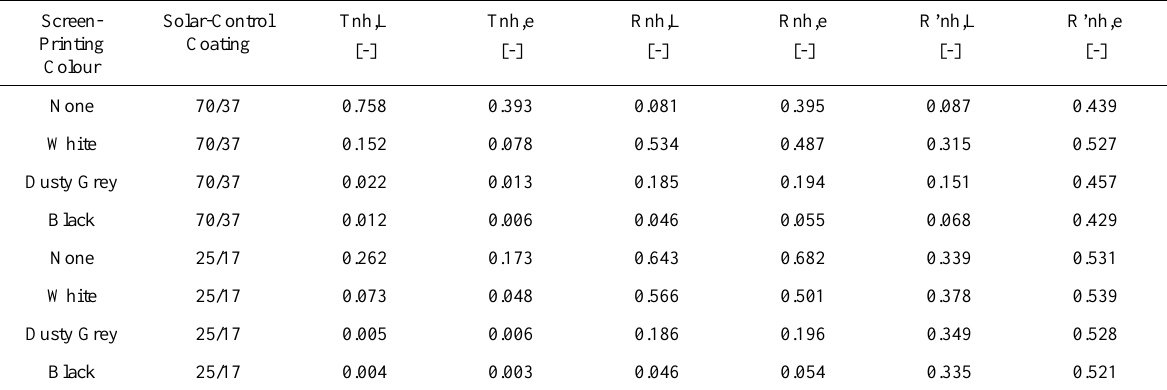
Table 2: Transmittance and reflectance values according to EN 410:2011 for 8 mm low-iron glass panes with a solar-control coating, with and without a screen-printed, fritted layer, measured using an integrating sphere of 620 mm diameter. The results are shown for two different solar- control coatings, with the designation 70/37, for example, indicating a coating which, in a double-glazed solar-control glazing unit, results in Tnh,L = 0.70 and g = 0.37. T = transmittance, R = reflectance (from the glass side), R’ = reflectance (from the coated side), nh = normal- hemispherical, L = light, e = (solar) energy. Only the first two digits after the decimal point are significant. The third digit after the point is used only to indicate very small differences. Screen-